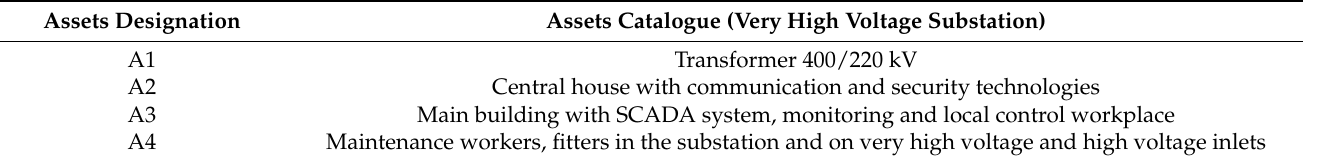
Table 2. Identified assets for the reference